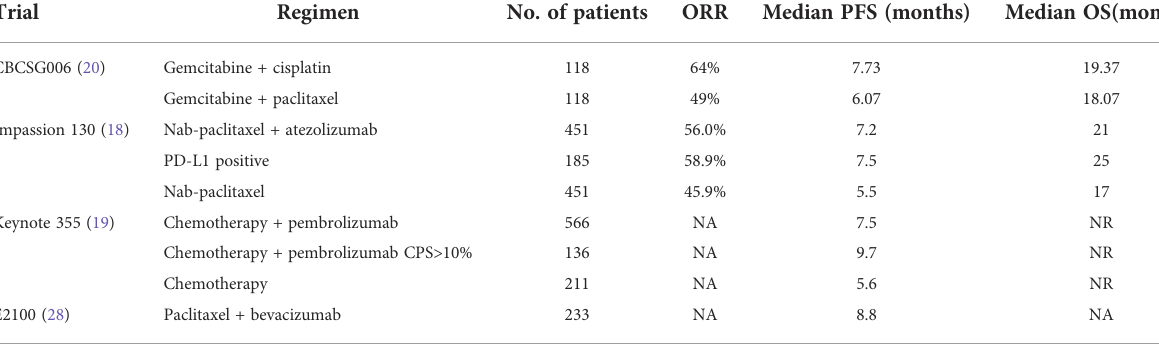
TABLE 5 Response and survival data from some classical phase III trials in the fi rst-line setting in